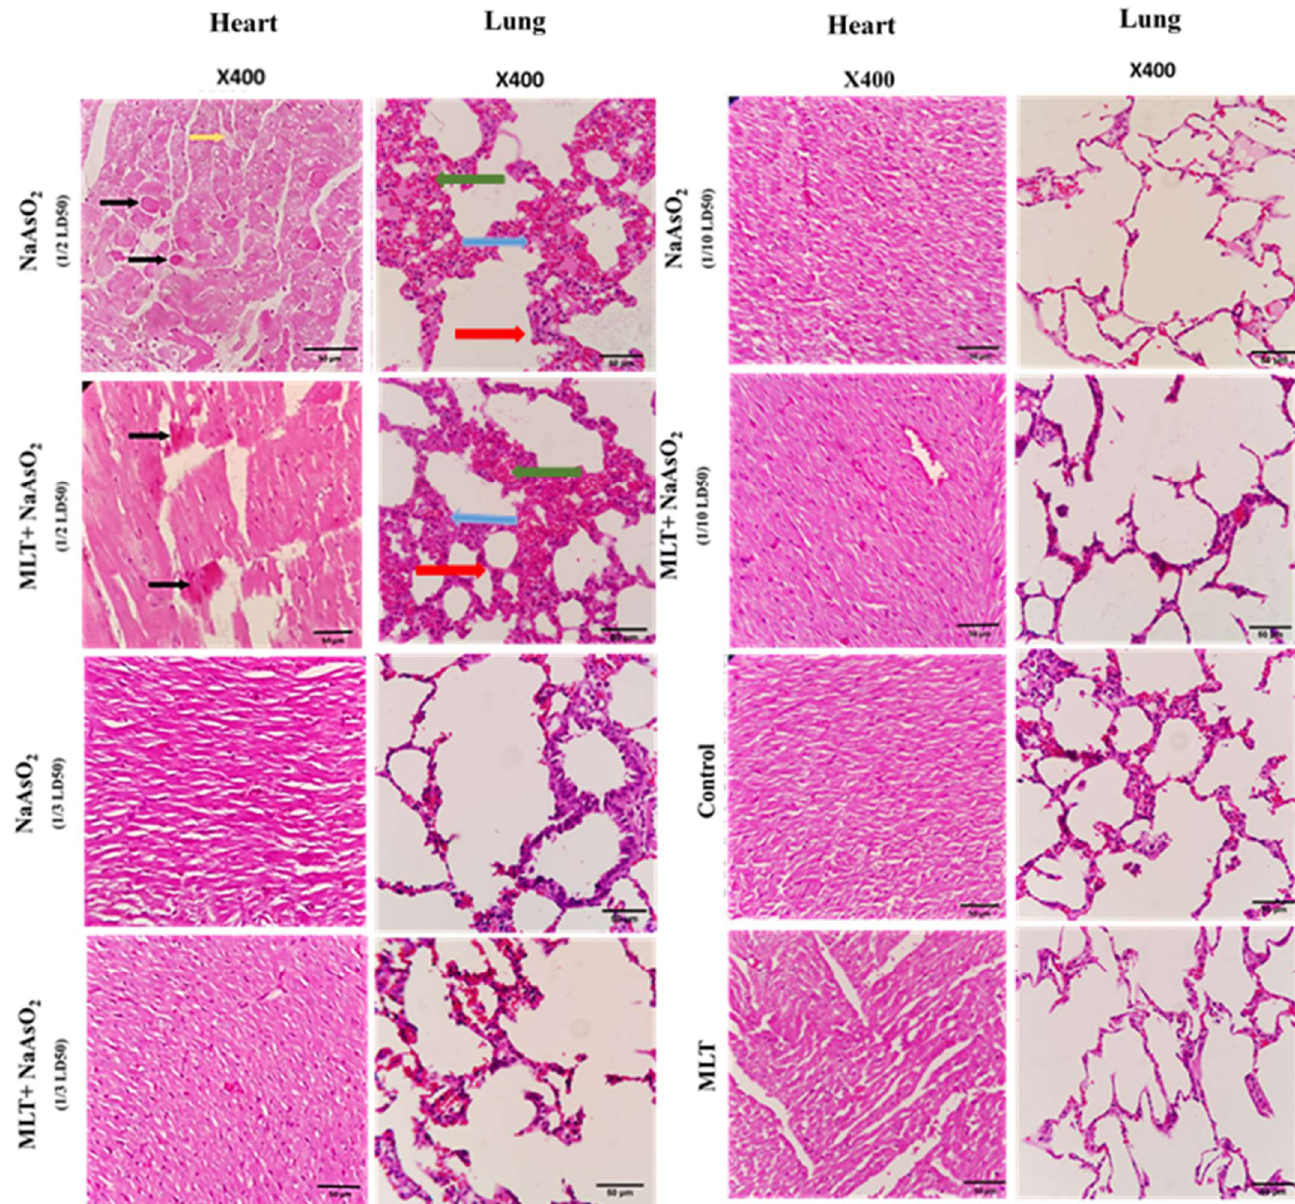
Figure 5. Hematoxylin–eosin-stained sections of tissues retrieved from animals treated with melatonin and arsenic in 1/2, 1/3, 1/10 doses, obtained at sacrifice after 30 days’ post-treatment. Black arrow refers to myocardial necrosis, Red arrow refers to inflammatory cells, Blue refers to Edema, Green arrow refers to hyperemia.